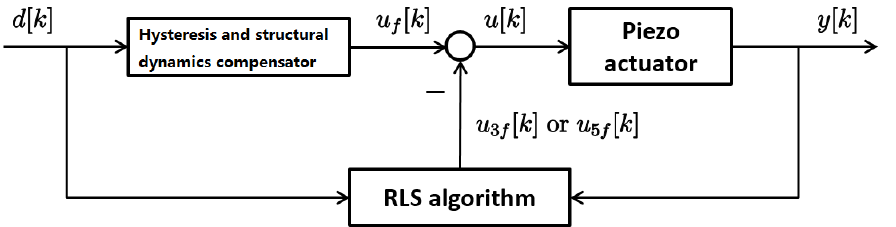
Figure 14. Proposed hysteresis compensator with the third/fifth harmonics attenuation. RLS: recursive least square.